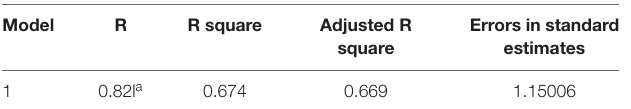
TABLE 4 | Model summary.